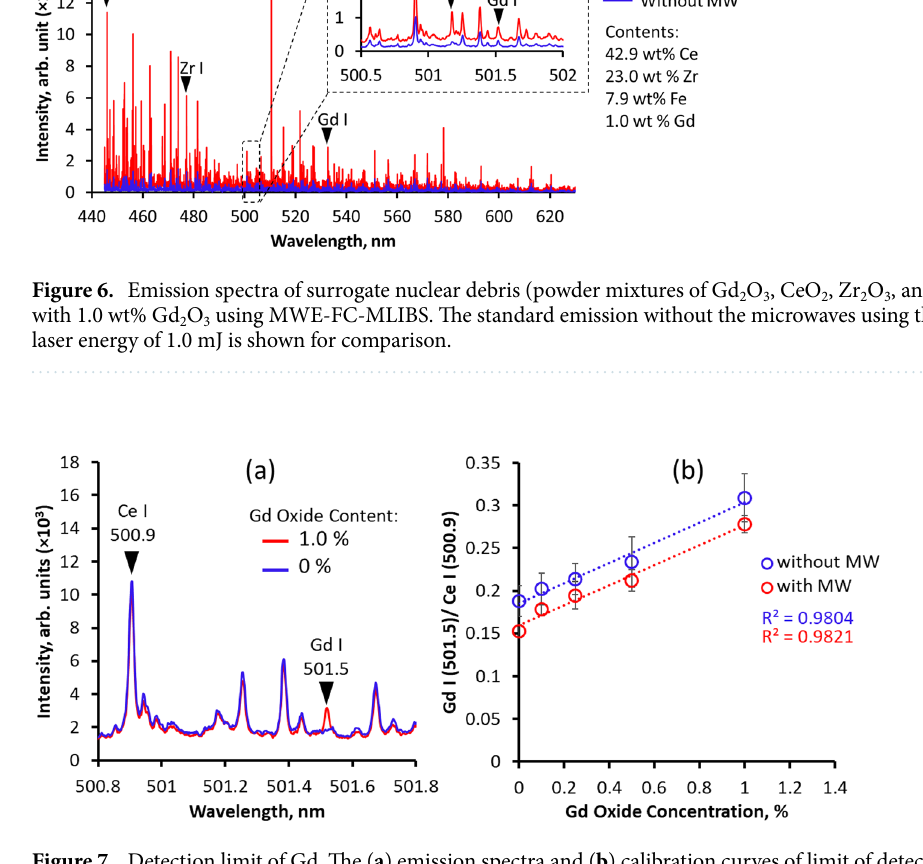
Figure 7. Detection limit of Gd. The ( a ) emission spectra and ( b ) calibration curves of limit of detection of Gd in surrogate nuclear debris.